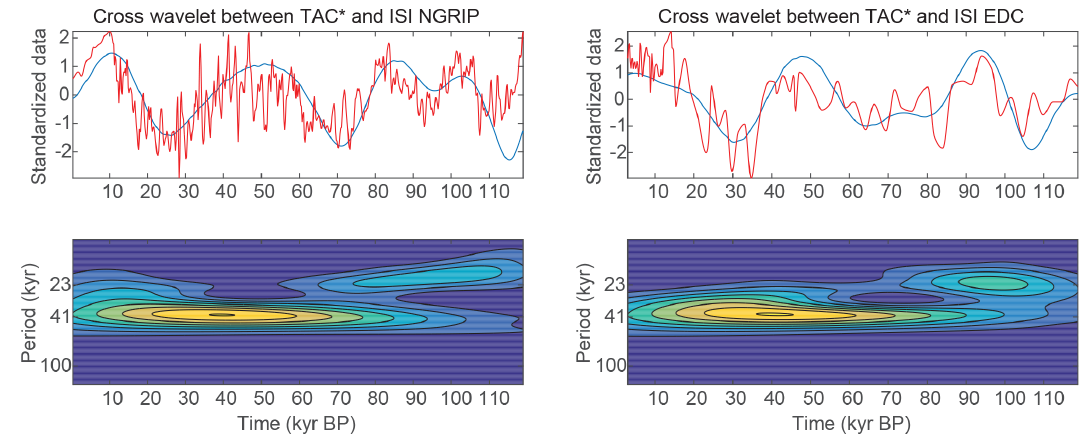
Figure 7. Left: the TAC ∗ data, resampled at 0.2kyr in red; sISI with a threshold of 390Wm − 2 in blue, splined with a 3kyr cutoff period and cross-wavelet analysis thereof. Both records show coherence in the obliquity and precession bands. Right: EDC TAC ∗ (Raynaud et al., 2007) resampled at 0.2kyr, sISI (75.1 ◦ S) with a threshold of 380Wm − 2 and cross-wavelet analysis of the EDC and sISI.